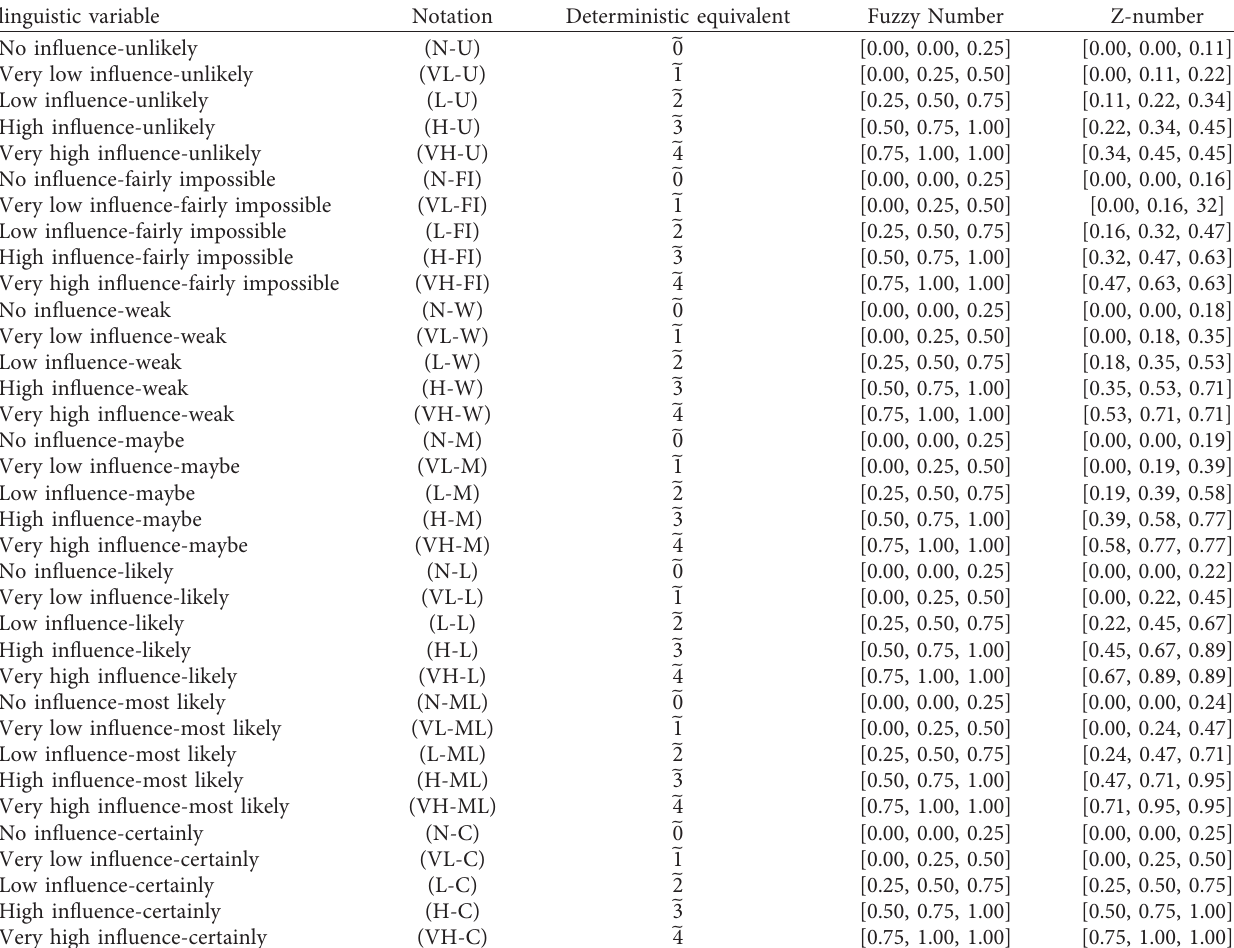
Table 6: The linguistic variables used and their corresponding Z-numbers.